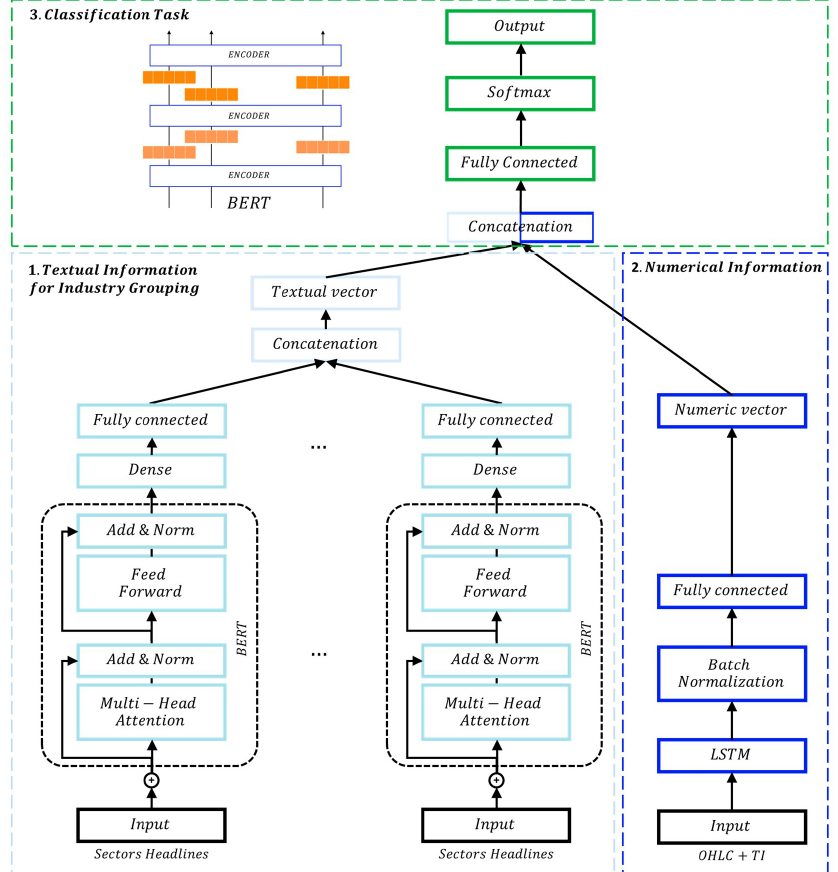
Figure 3. Our proposed model using numerical inputs and sector-based textual